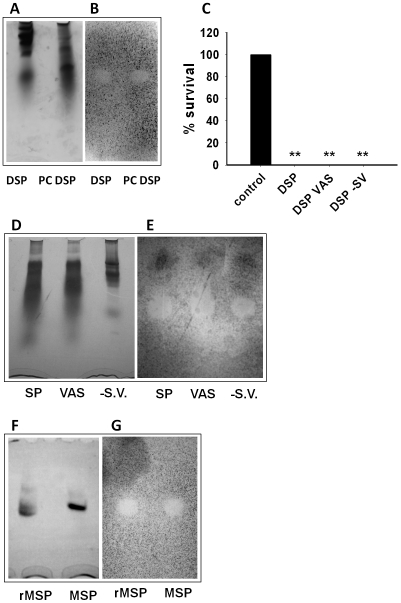
Antifungal gel overlay assays with seminal plasma and MSP.Post coital seminal dialyzed plasma (PC DSP) and seminal plasma (DSP) were analyzed on an AU-PAGE gel and analyzed by coomassie staining (A) or in an antifungal gel overlay assay with C. albicans. (B). Clearing zones depict antifungal activity. The antifungal activity of dialyzed normal seminal plasma (DSP), seminal plasma from a vasectomized patient (DSP VAS), and a patient with deficient seminal vesicles (DSP -SV) were analyzed by CFU assay (C). Results are shown as the average of three independent experiments. ** denotes p<0.001. Complete killing was found in the three samples of seminal plasma and, consequently, no error bars are shown. Further details regarding the statistical analysis are found in Dataset S1. Normal seminal plasma (SP), seminal plasma from a vasectomized patient (VAS), and from a patient with deficient seminal vesicles (-SV) were analyzed on an AU-PAGE gel by coomassie staining (D) or in an antifungal gel overlay assay with C. albicans (E). Recombinant MSP (rMSP) or native MSP were analyzed by AU-PAGE gel by coomassie staining (F) or in an antifungal gel overlay assay with C. albicans (G). MSP gave clearing zones migrating identically to the zones found in seminal plasma. Acid-urea PAGE is a non-detergent based PAGE where the electrophoretic mobility of a protein is determined both by charge and size. Two proteins of similar size can consequently have very different mobility. Accordingly, molecular size standards were not used.